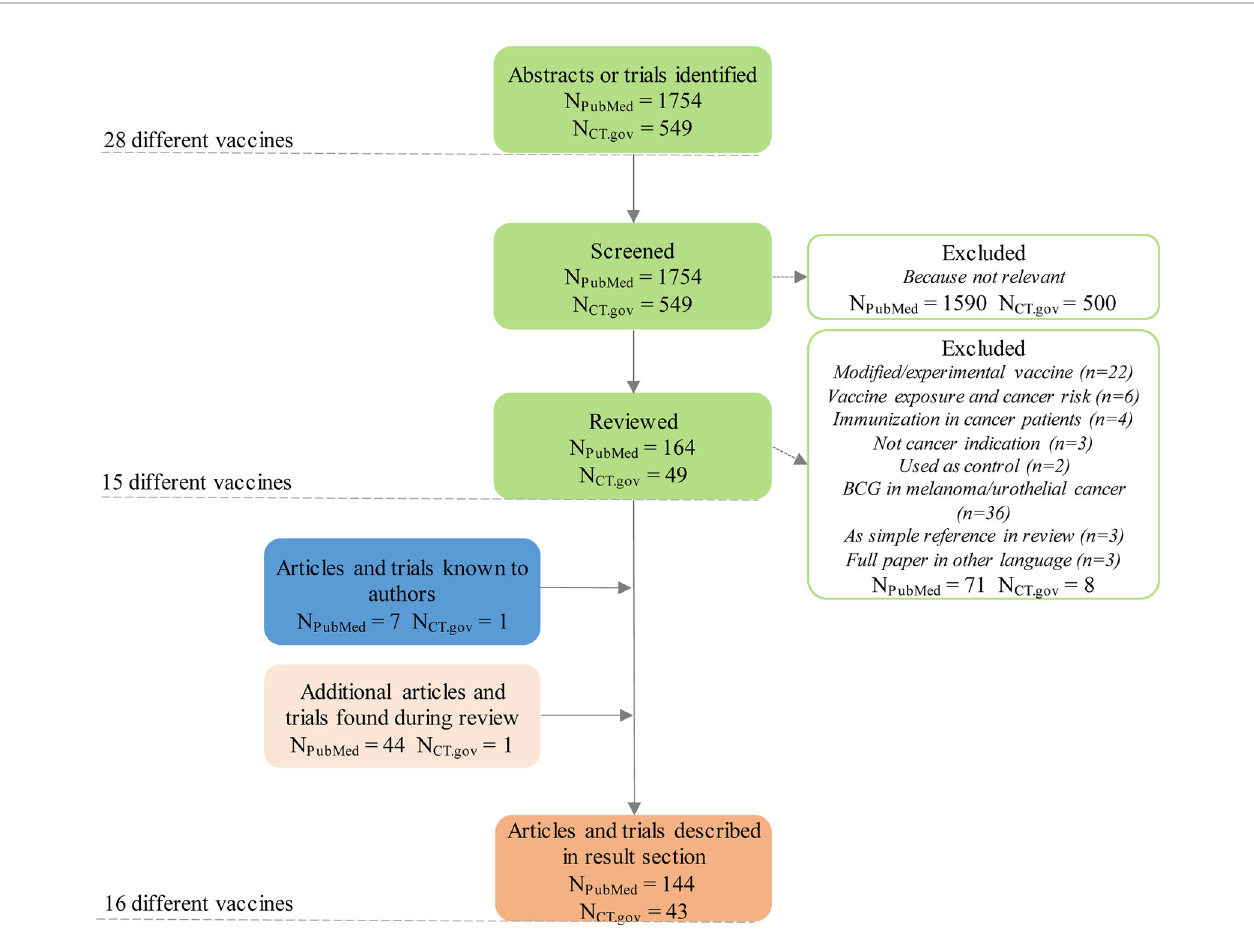
FIGURE 1 | Flow chart of the selection of relevant hits identi fi ed through the different queries. N PubMed = articles identi fi ed through PubMed database query; N CT.gov = clinical trials identi fi ed through clinicaltrials.gov database